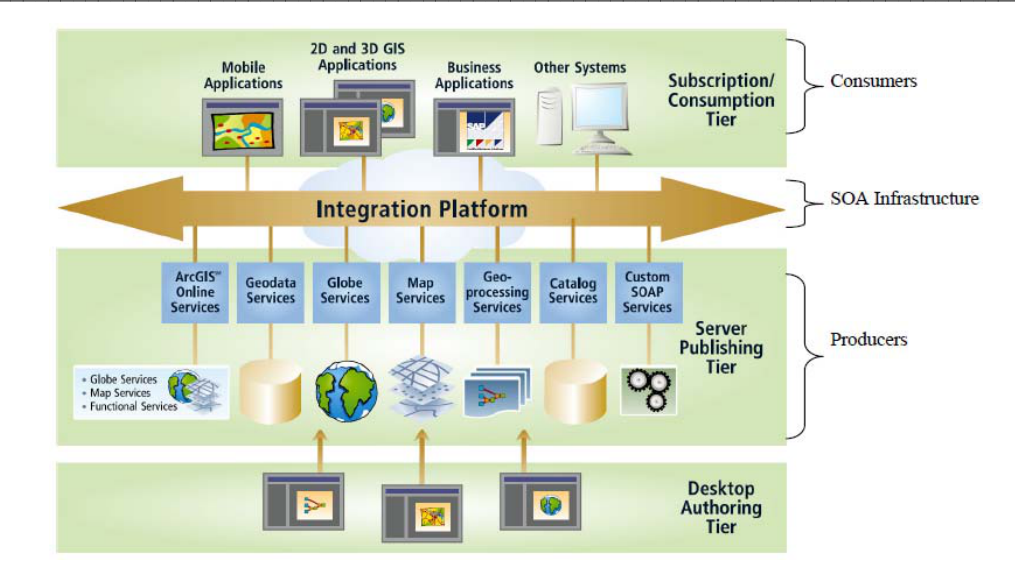
Fig. 1. GIS SOA conceptual model